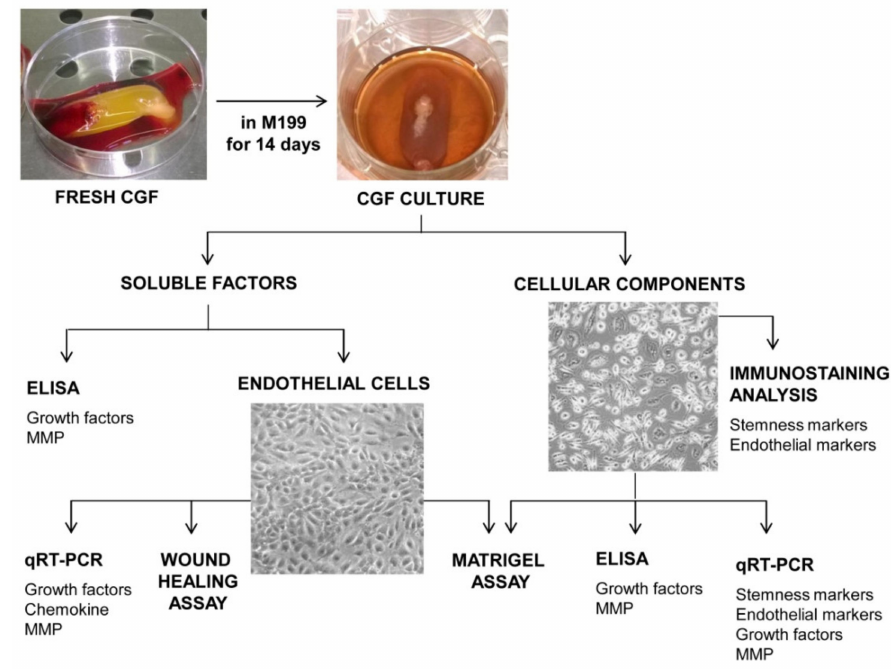
Figure 1. Experimental